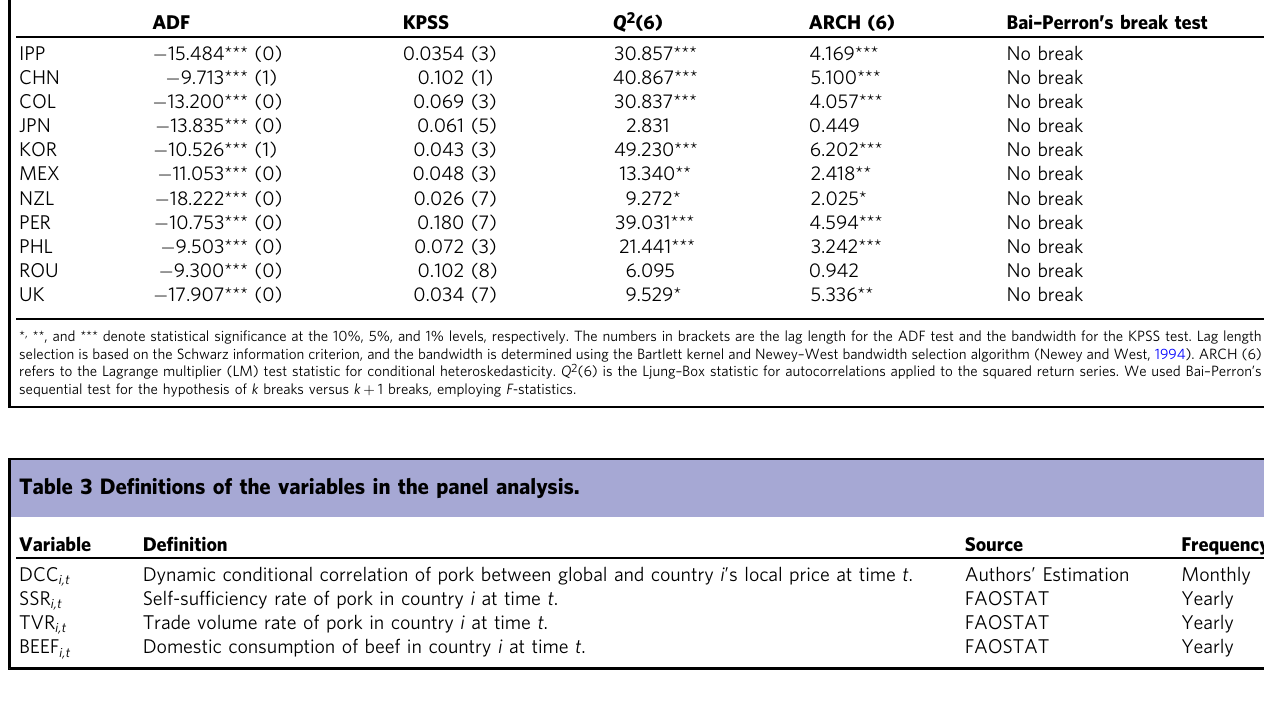
Table 4 Summary statistics for the explanatory variables in the panel analysis.